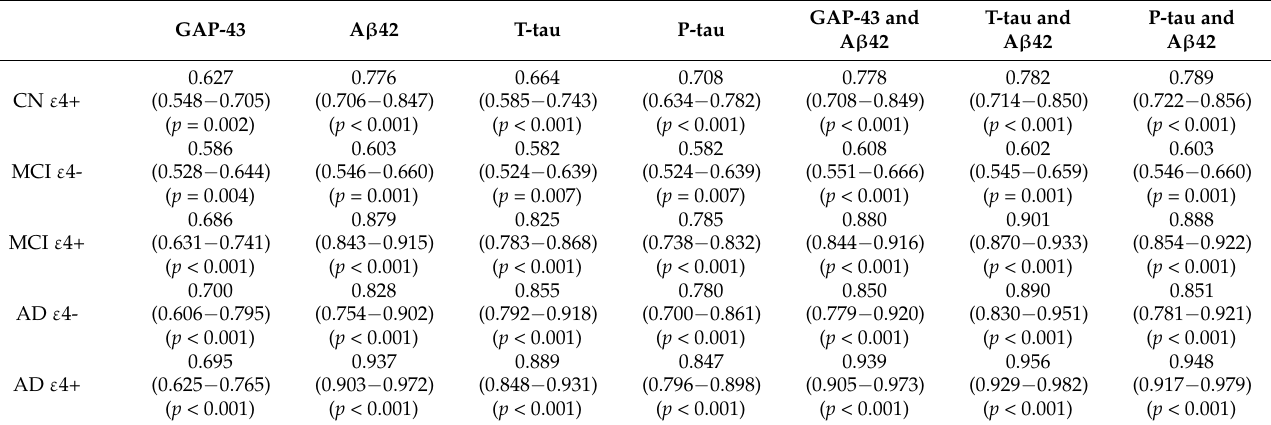
Table 3. AUCs of CSF biomarkers for clinical